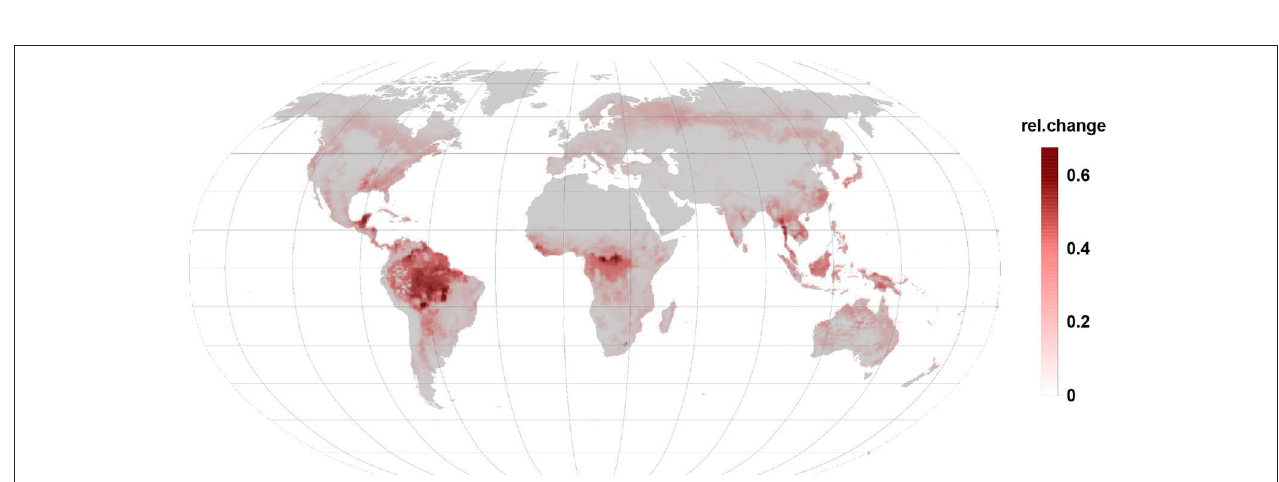
FIGURE 4 | Relative changes in monoterpene emission are of the same order than isoprene changes but they increase emissions. Besides the tropic and subtropic areas they are more prominent in temperate and boreal regions.